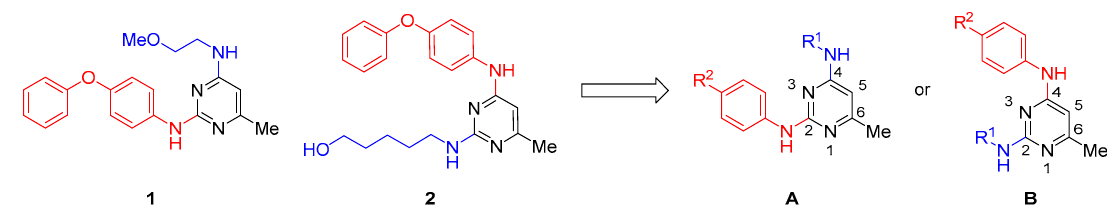
Figure 2. Design strategy for the construction of pyrimidine library.